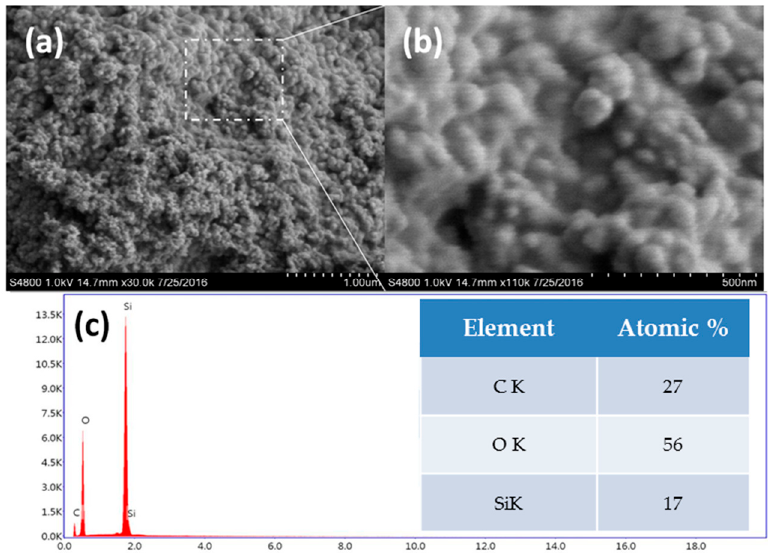
Figure 1. Transmission electron microscopy (TEM) image of ( a ) polydimethylsiloxane (PDMS)- SiO 2 and ( b ) PDMS-SiO 2 /PFA with a mass ratio of PDMS-SiO 2 to PFA of 0.5.